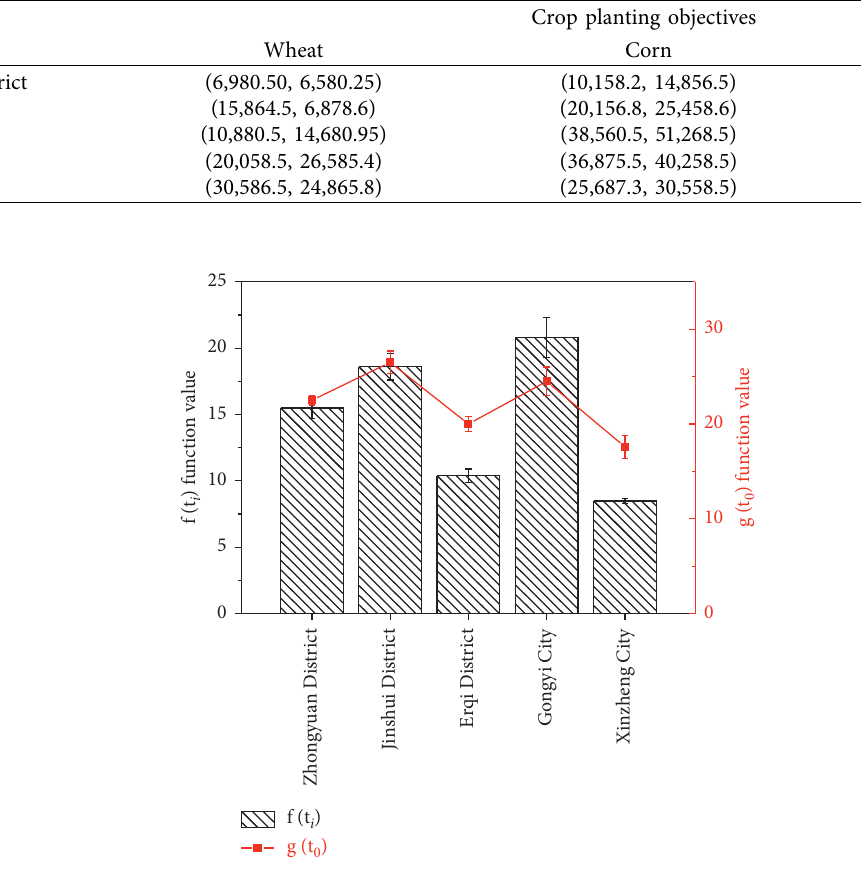
g ( t i ) and 0 ) calculated according to the fuzzy linear programming